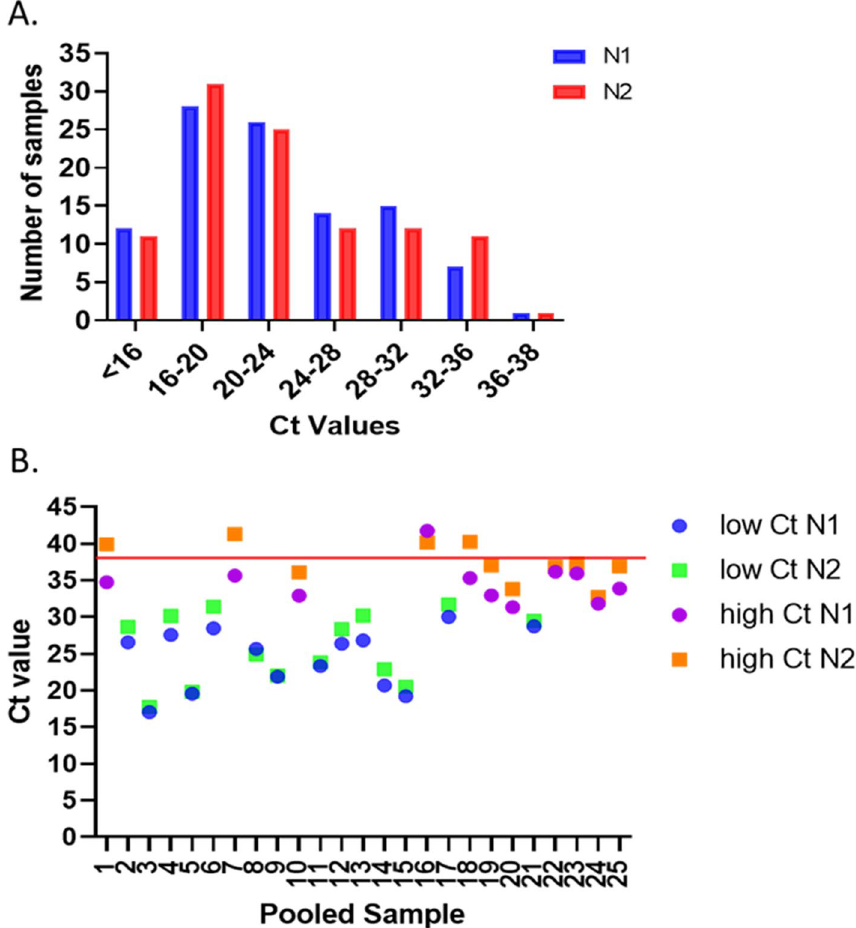
Figure 4. 5-sample pool SARS-CoV-2 RT-PCR assay development. ( A ) Analysis of the first 103 positive samples from 2021 binned to visualize N1 and N2 Ct level. ( B ) Pools of 5 samples containing one positive sample per pool. Positive samples were chosen to represent the occupational sample population (14 low Ct samples) and to examine the effect of 5 sample pools on high Ct samples (11 samples), which could be missed due to the Ct delay caused by